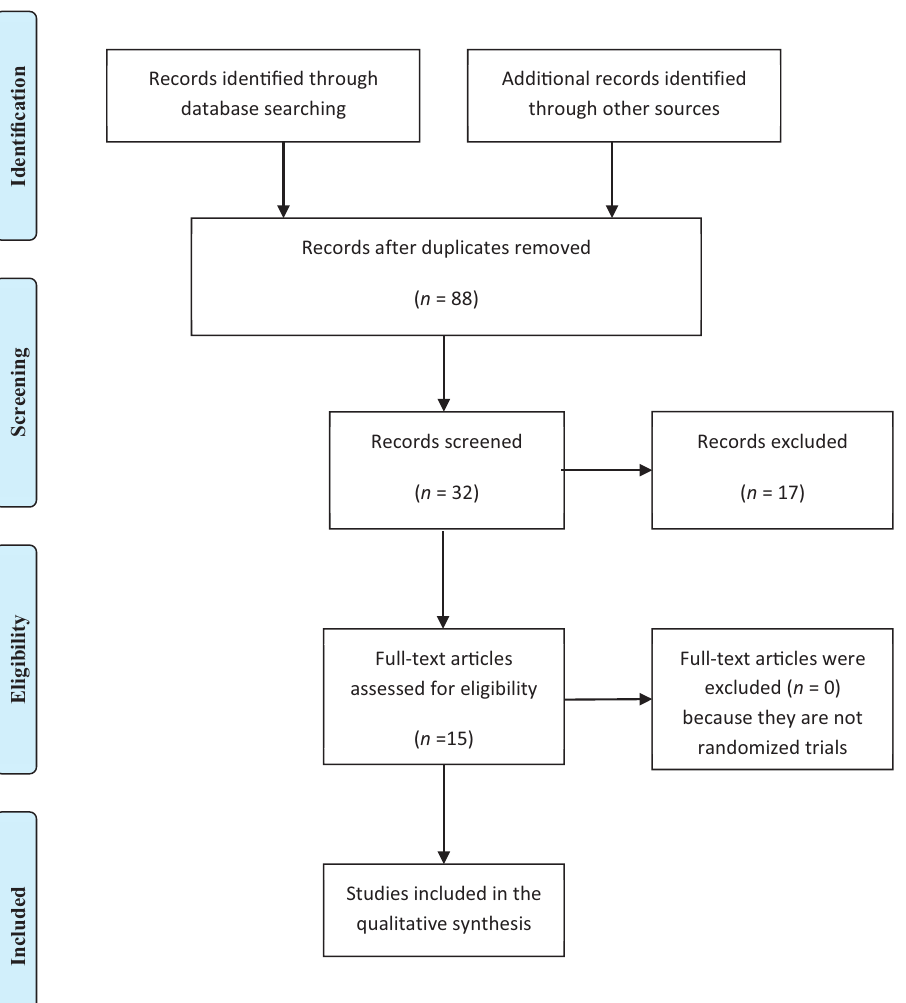
Figure 1 : The effect of long thyroid-stimulating hormone (TSH)-suppressive therapy (following surgery for differentiated thyroid carcinoma) on bone mineral density